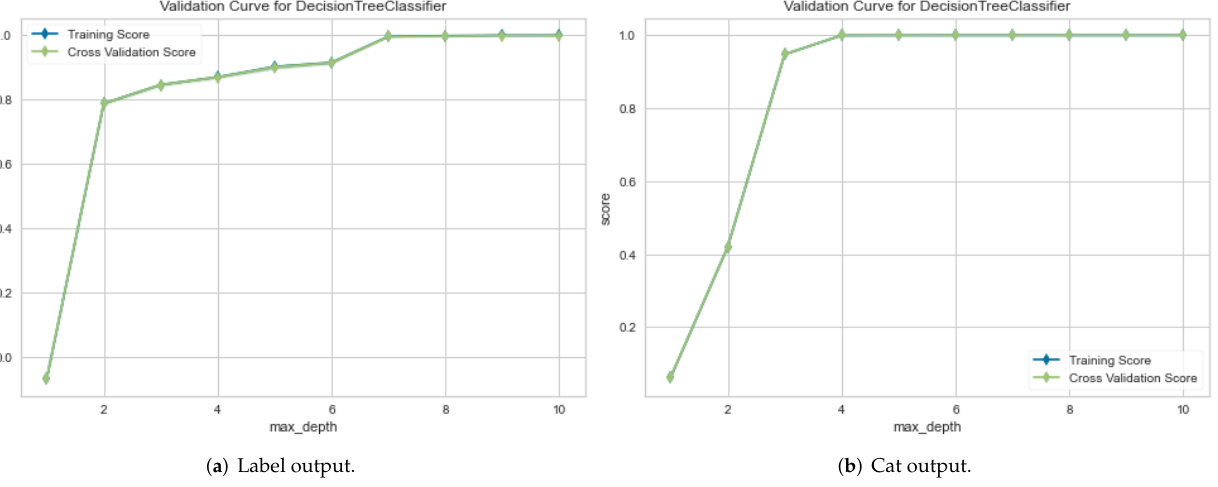
Figure 7. Validation curve results for IoTID20 dataset in two cases: ( a ) Binary class output and